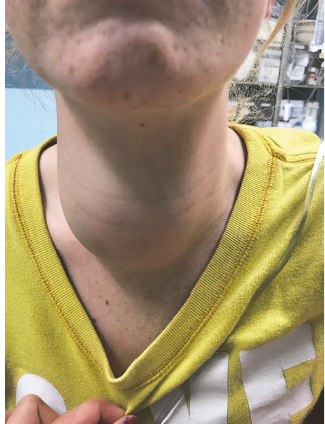
Figure 1: Anterior neck mass on the day of